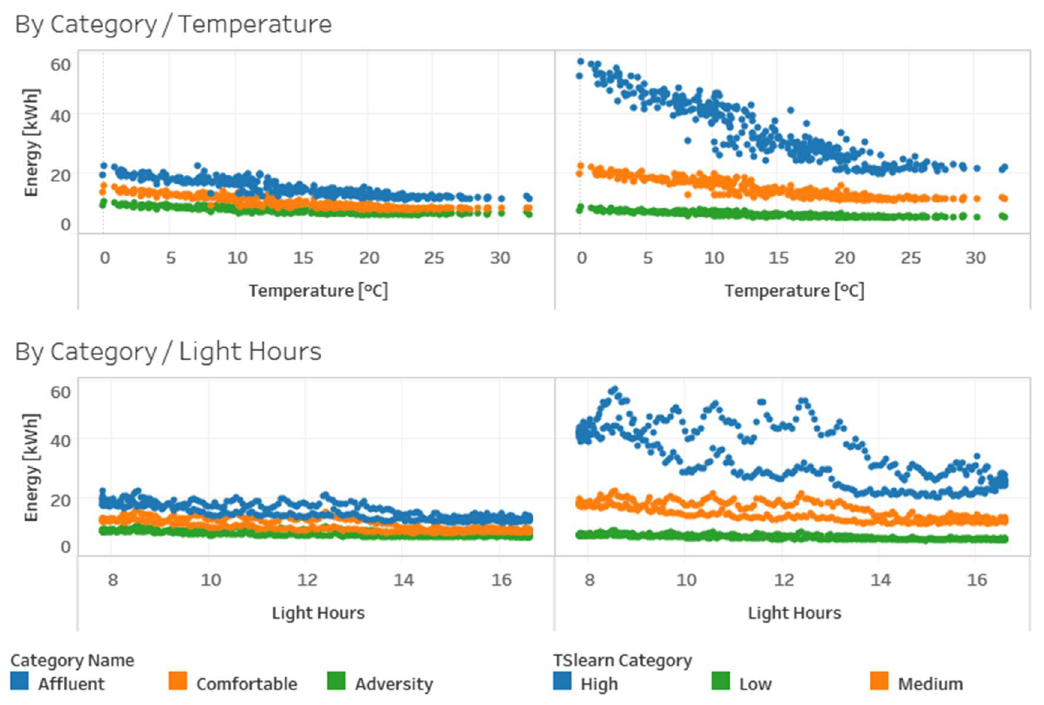
Figure 12. Energy consumption vs. temperature and light hours for grouped and TSlearn categories.